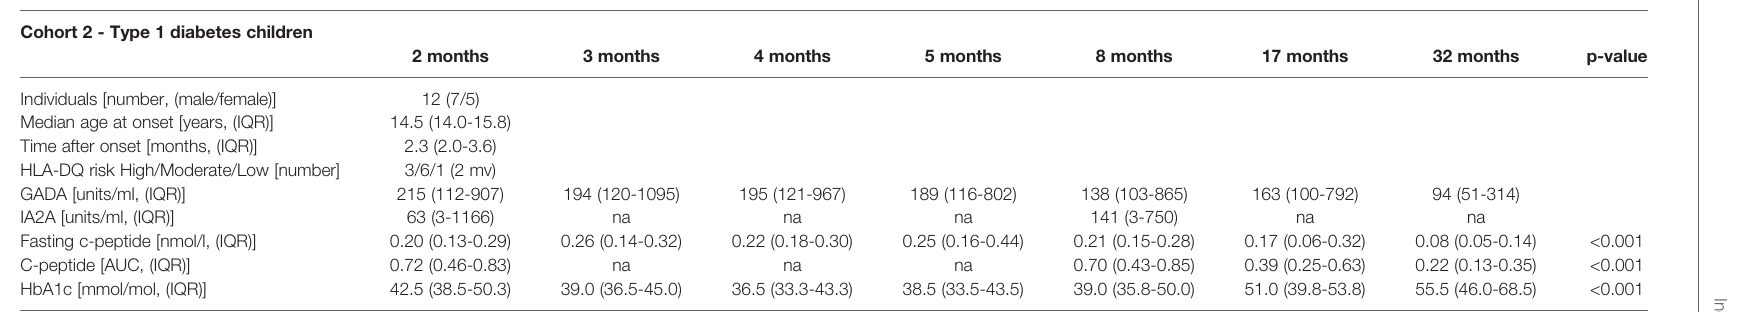
na, not available. mv, missing values.